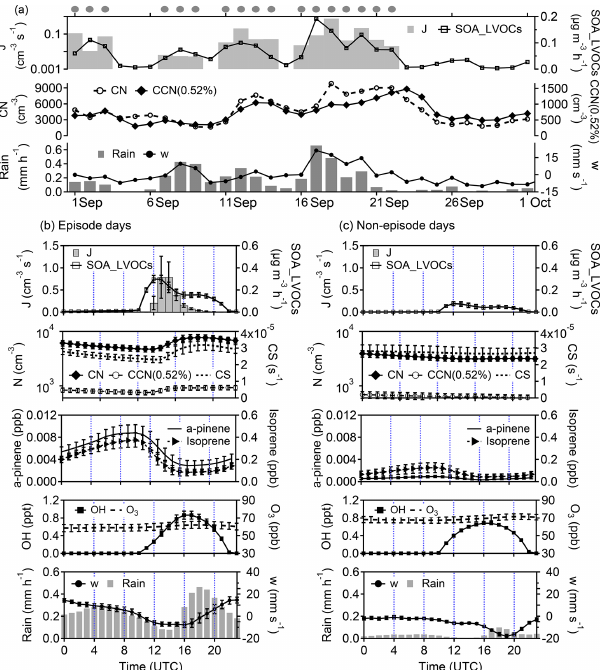
Figure 4. Modeled temporal variation of the rate and precursors of organic nucleation and condensation as well as meteorological variables. (a) Daily variation of regionally averaged nucleation and condensation rates, number concentration of CN and CCN at 0.52% supersaturation (CCN(0.52%)), vertical wind at 8km ( w ), and pre- cipitation. The dots above the figure mark the upper-tropospheric biogenic SOA episodes. The diurnal patterns of nucleation and con- densation rate, number concentration of CN and CCN(0.52%), con- densation sink of HOMs, and mixing ratio of α -pinene, isoprene, O 3 , and OH average in the upper troposphere as well as the vertical wind at 8km and precipitation for the (b) upper-tropospheric bio- genic SOA episode days and (c) non-episode days. The bars denote the standard error. The concentrations of gases and aerosols, the production rates, and the condensation sink are normalized to STP. The analyzed region is indicated by the black rectangle in Fig.